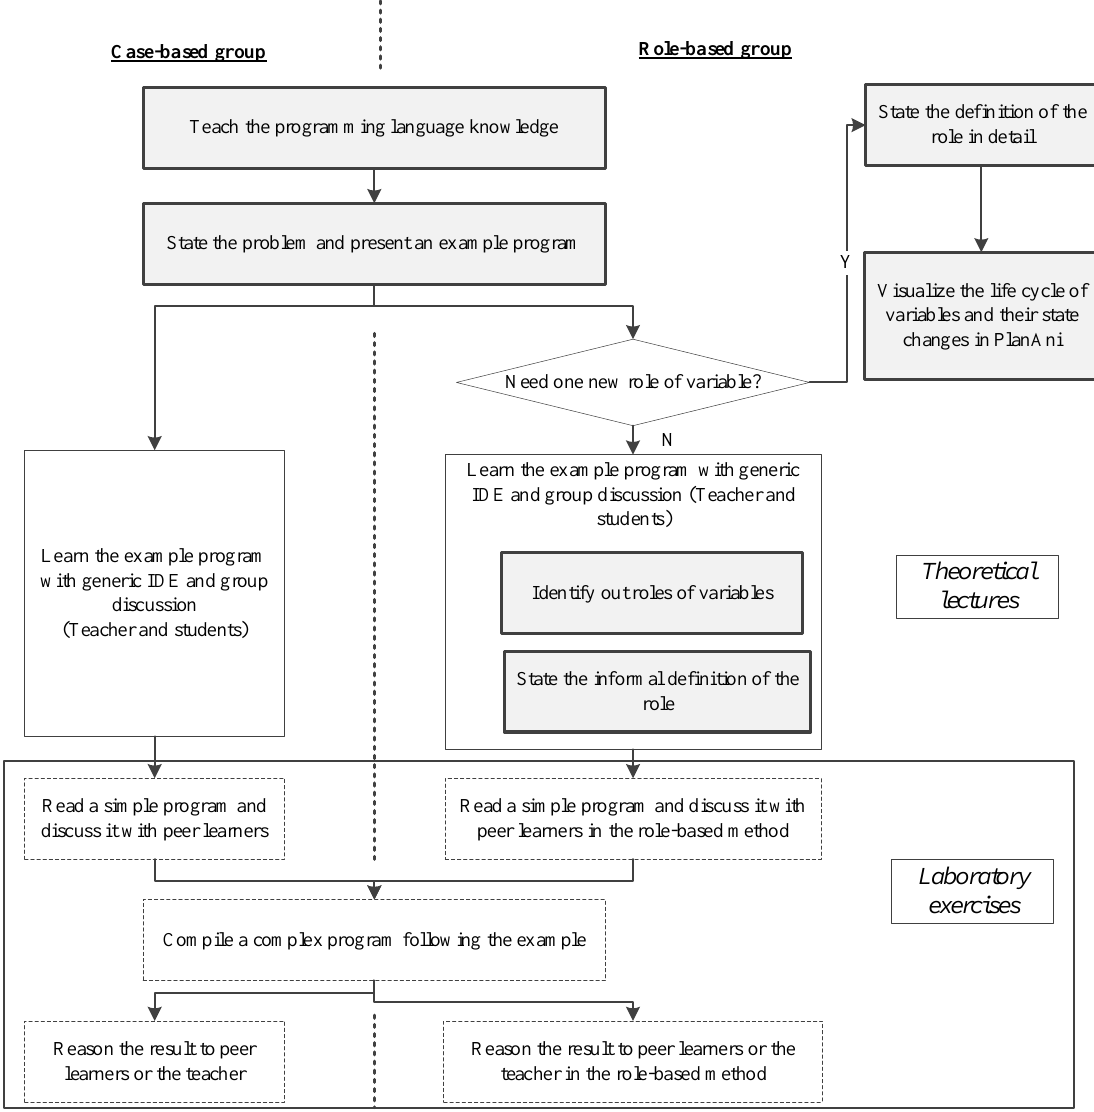
Figure 2. Pedagogical activities in the control and experimental groups.